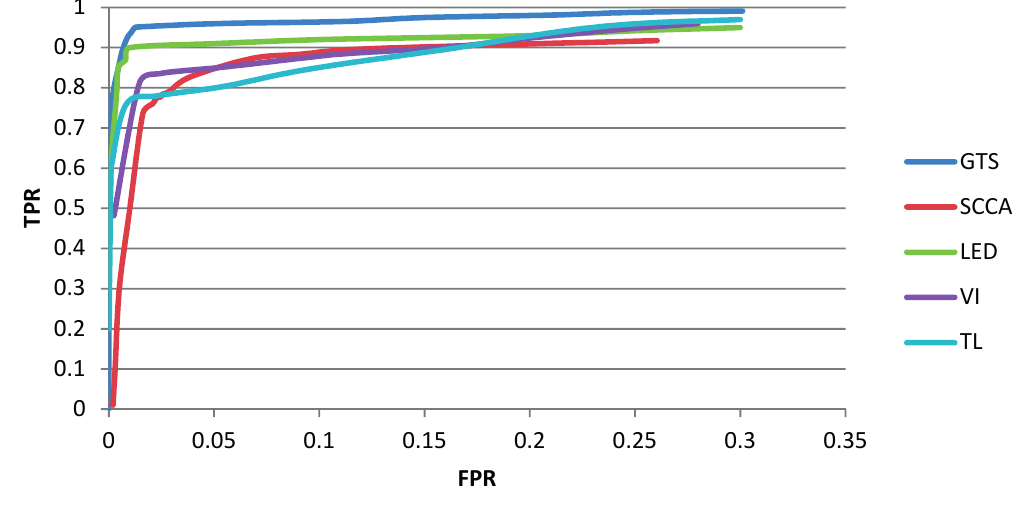
Figure 12. The ROC curves of the detectors for